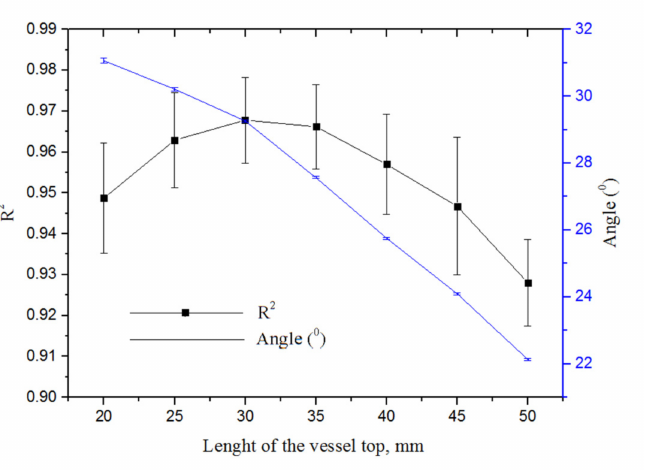
Figure 6. Results of the linear fitting and angle between fitted line and horizontal axis according to the various length of the inner vessel top.